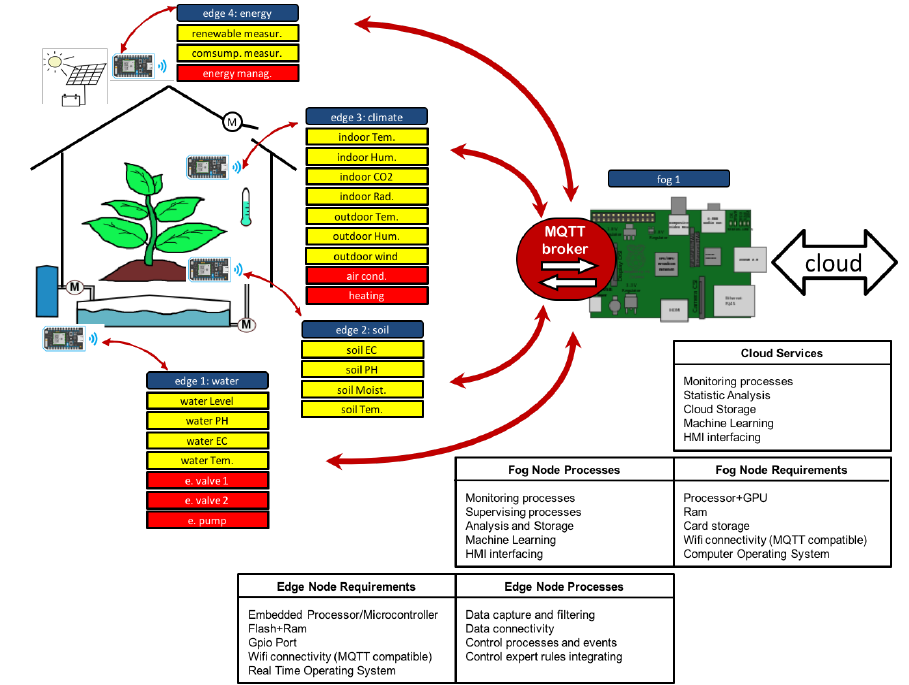
Figure 7. Greenhouse design. Fog and edge nodes relations on agriculture